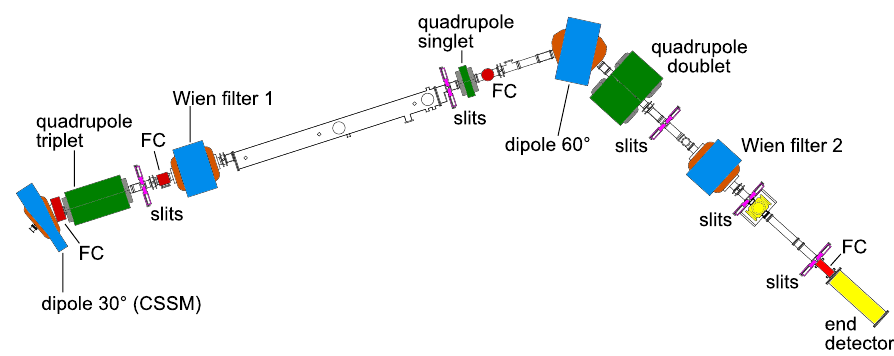
Figure 1. Layout of the ERNA RMS at the CIRCE-DMF Tandem Accelerator Laboratory. CSSM indicates the charge state selection magnet; FC indicates the Faraday cups along the separator